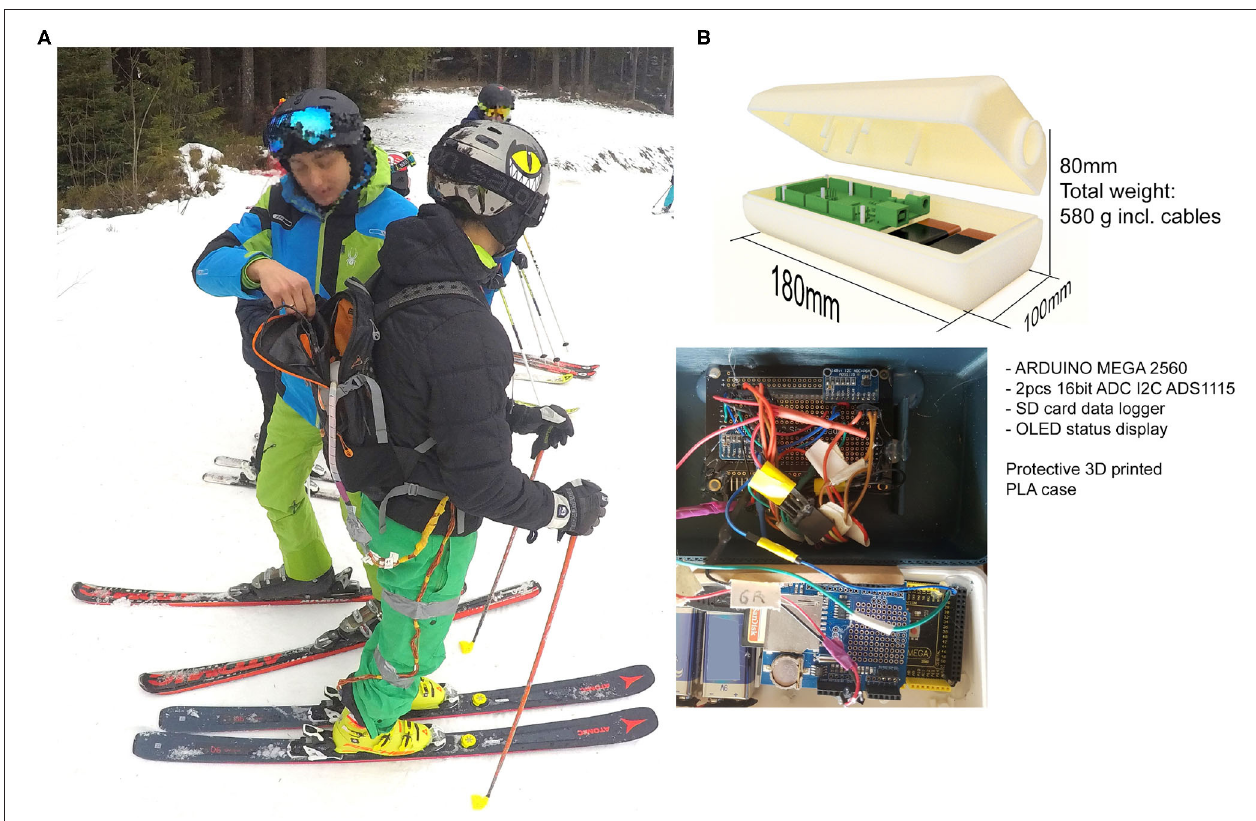
FIGURE 2 | (A) Data acquisition system in a small backpack. (B) 3D-printed case of the DAQ system including the wiring of the sensor.